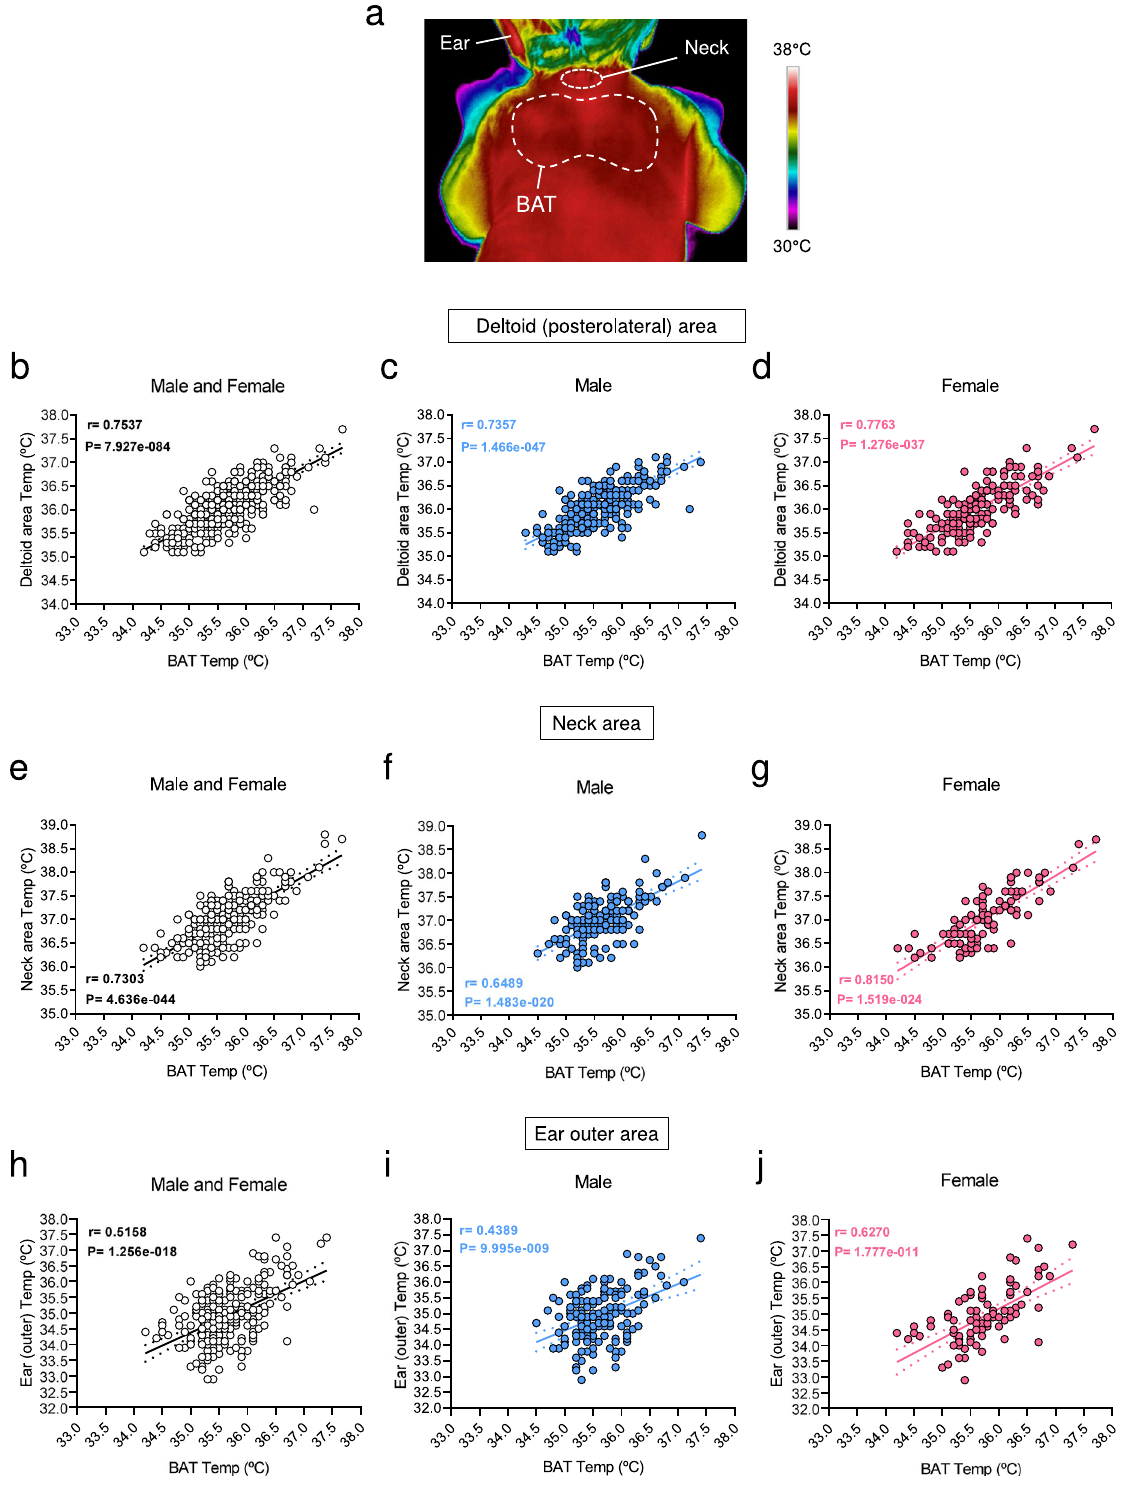
Fig. 1 Correlations between BAT and body temperature in newborns. a Representative thermal images and b – j correlation between body (deltoid, neck, and ear) and BAT temperatures in newborns. Number of newborns: b 449, c 270, d 179, e 255, f 158, g 97, h 249, i 156, j 93. Association analysis was performed by two-sided Pearson ’ s test; regression line with 95% con fi dence interval was added when correlation was signi fi cant. Source data are provided as a Source data fi